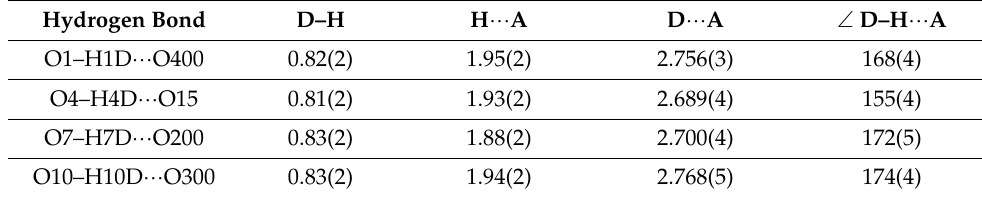
Table 2. Hydrogen-bonding geometry (Å, °).